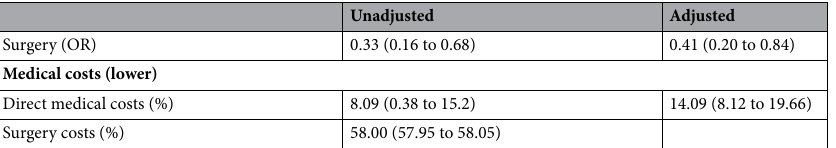
Table 3. The effects of COC on surgery and medical costs. The reference group is low COC group (COC < 0.50 [median]). Effects of COC on surgery cost was estimated using a two-part model. Adjusted covariates are age in category, Gender, Coverage type, frozen shoulder, shoulder impingement syndrome, Charlson comorbidity index, primary provider type, and the total number of medical visits.